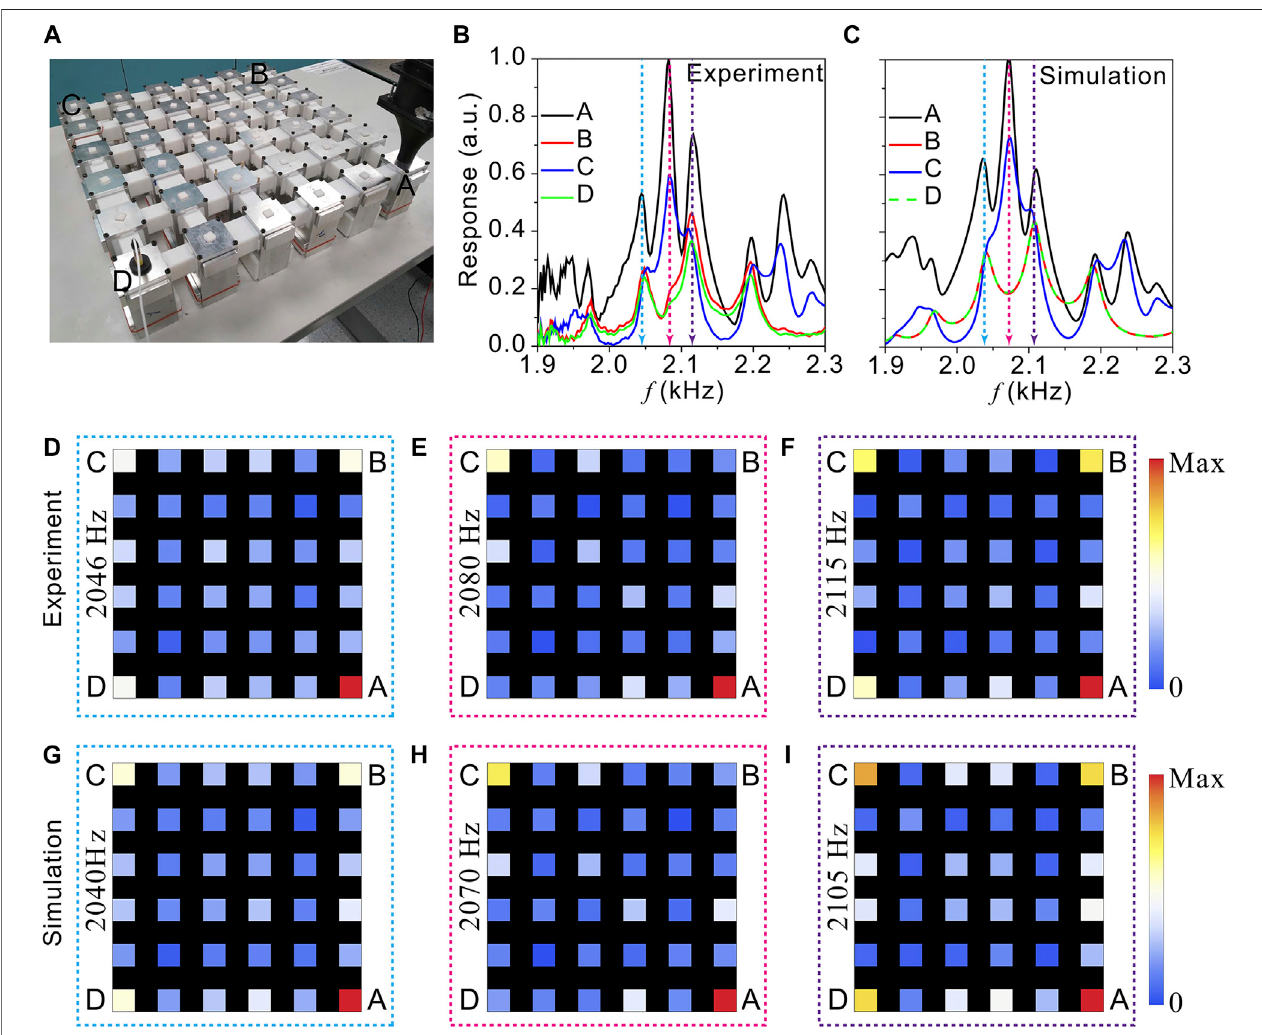
FIGURE 3 | (A) A photograph showing the fabricated TDI phononic crystal. (B – C) Measured (B) and simulated (C) corner responses. (D – F) Measured responses at thefrequencies corner-mode resonant peaks: (D) 2046Hz, (E) 2080Hz, (F) 2115 Hz. (G – I) Simulated responsesat thefrequenciescorner-moderesonant peaks: